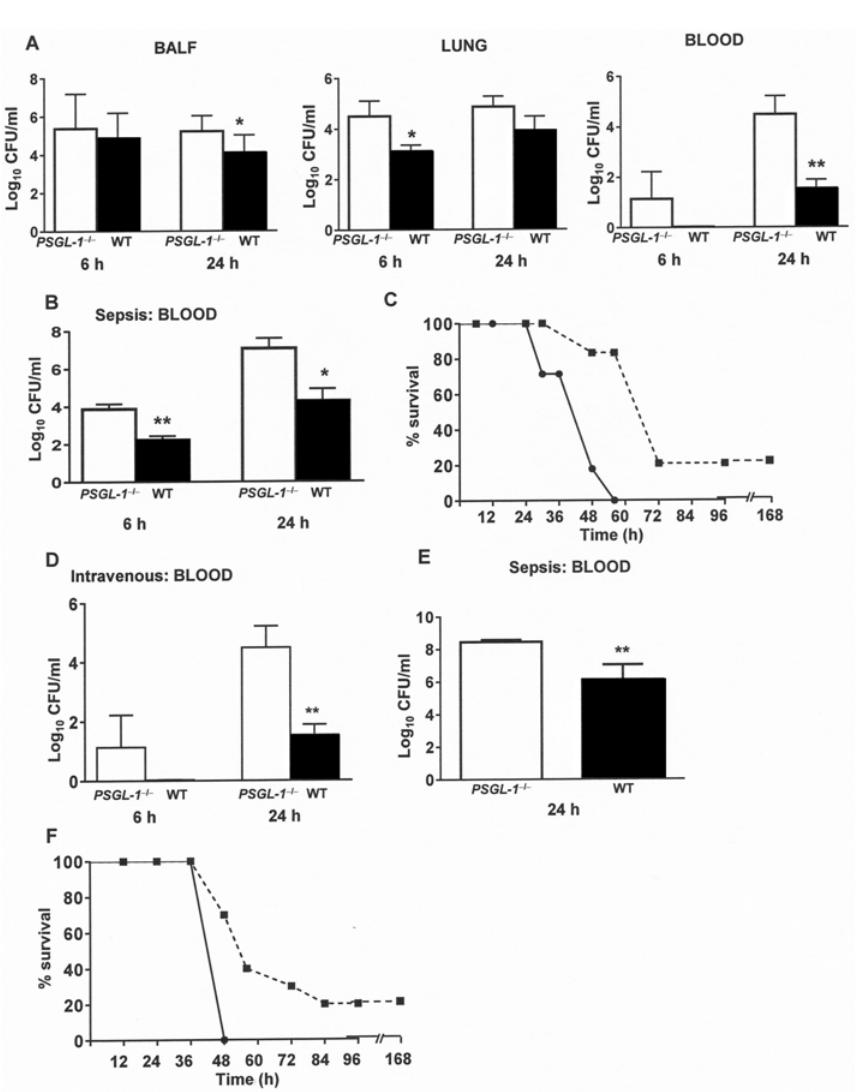
Fig 5. Contribution of PSGL-1 to host defense against invasive pneumococcal disease. (A) Bacterial levels recovered at 6 h and 24 h from BALF, lung and blood of PSGL-1 − / − mice (open bars) and wild-type mice (black bars) after pneumonia infection with the pneumococcal D39 strain. (B) Bacterial levels recovered from blood of PSGL-1 − / − mice (open bars) and wild-type mice (black bars) after sepsis caused by D39 strain. (C) Survival rates of PSGL-1 − / − mice (solid line) and wild-type mice (dotted line) after pneumococcal sepsis produced by D39 S . pneumoniae strain. (D) Bacterial levels recovered from blood of PSGL-1 − / − mice (open bars) and wild-type mice (black bars) after intravenous infection with D39 strain. (E-F) Bacterial counts in blood and survival of PSGL-1 − / − mice (open bars and solid line) and wild-type mice (black bars and dotted line) infected by the intraperitoneal route (sepsis) with TIGR4 strain. Error bars represent the SDs and asterisks indicate statistical significance of bacterial levels of PSGL-1 − / − mice compared to wild-type mice. For differences in survival between wild-type mice and PSGL1 − / − mice a long-rank test was used ( P < 0.01 for D39 strain and P < 0.05 for TIGR4